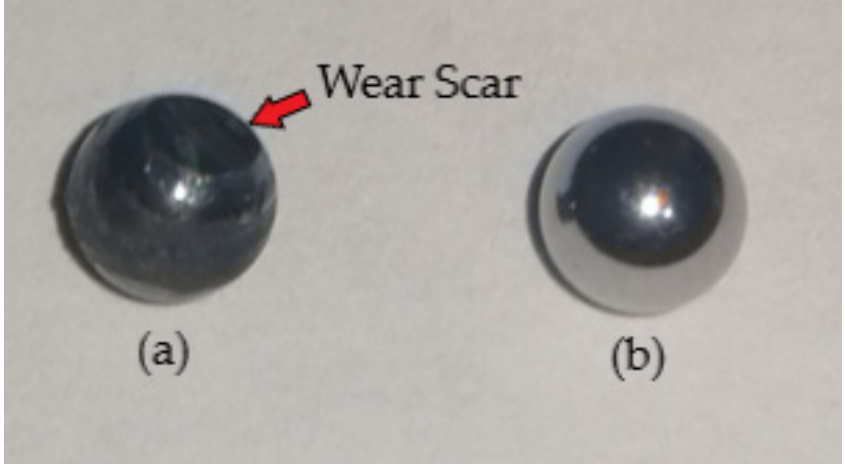
Figure 5. ( a ) Worn 4 mm diameter 52100 steel ball that typically represents pin-on-disc Test 1a, 1b, 2a and 2b for Coating A and Coating B; ( b ) unused 4 mm diameter 52100 steel ball.